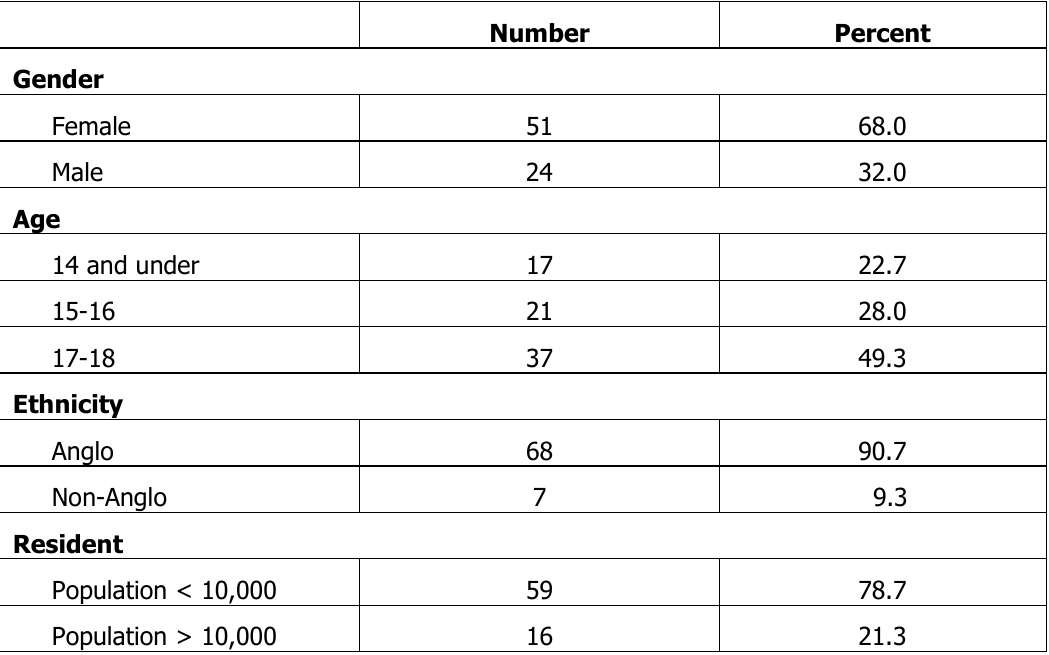
Demographics characteristics of Youth Board youth participants